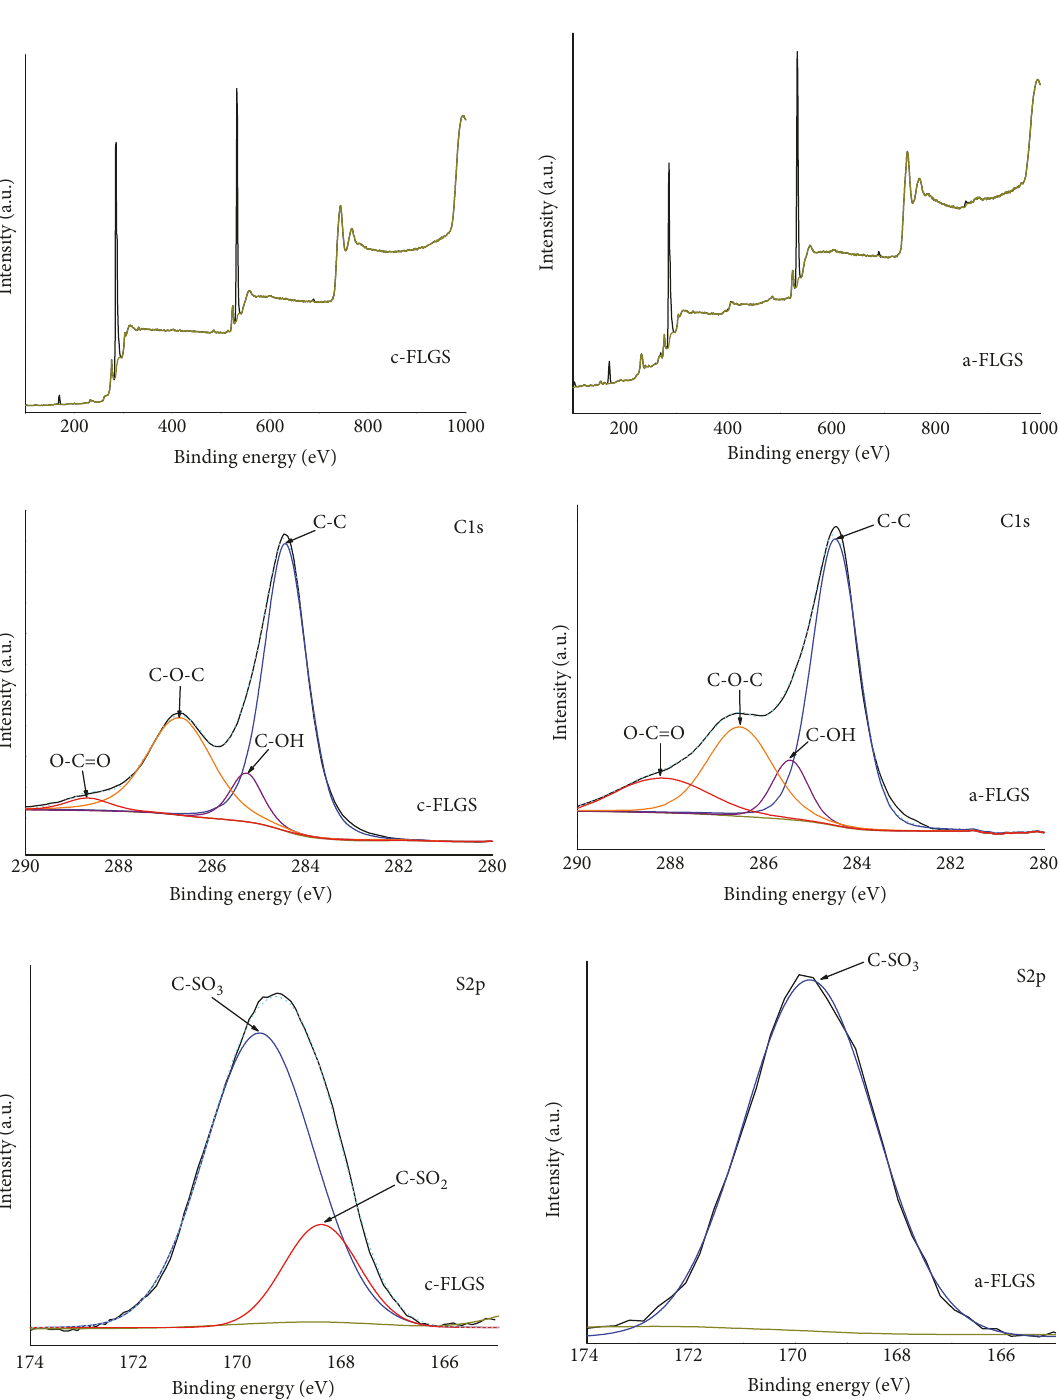
method of FLGS production (the usage of cathodic or anodic plasma) was not found to distinctly affect the conductivity when the environment in which the sample is located